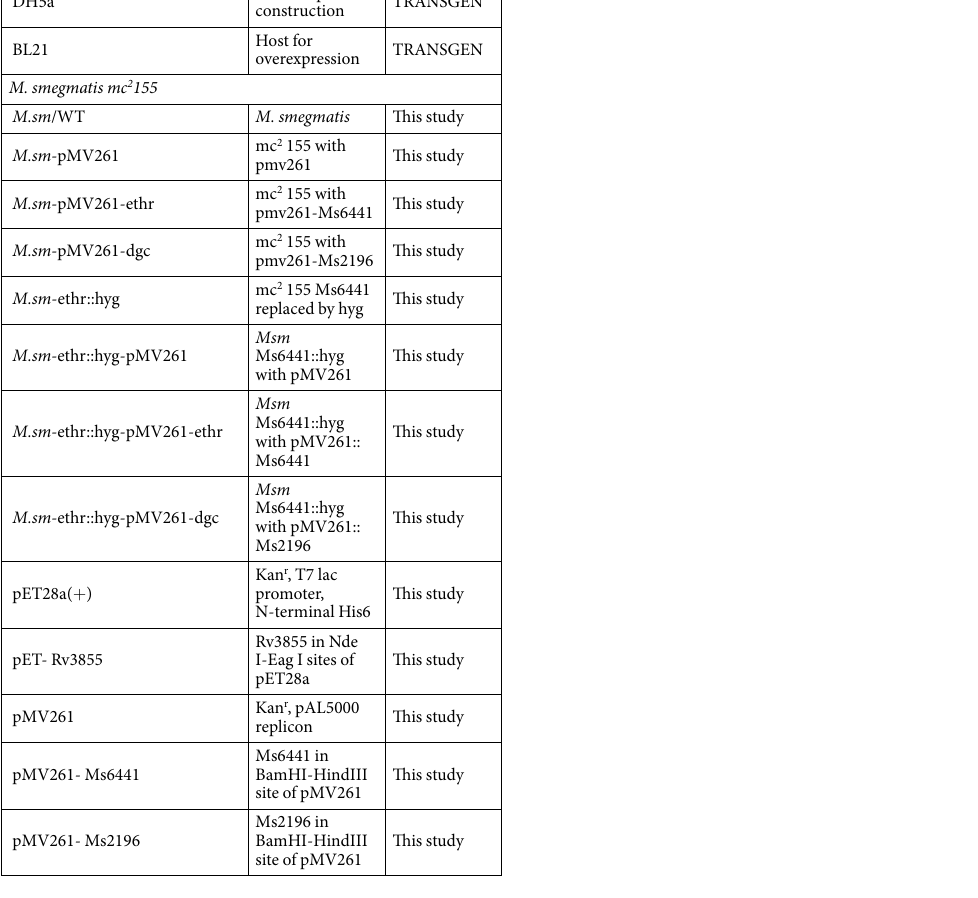
Table 1. Strains and plasmids used in this